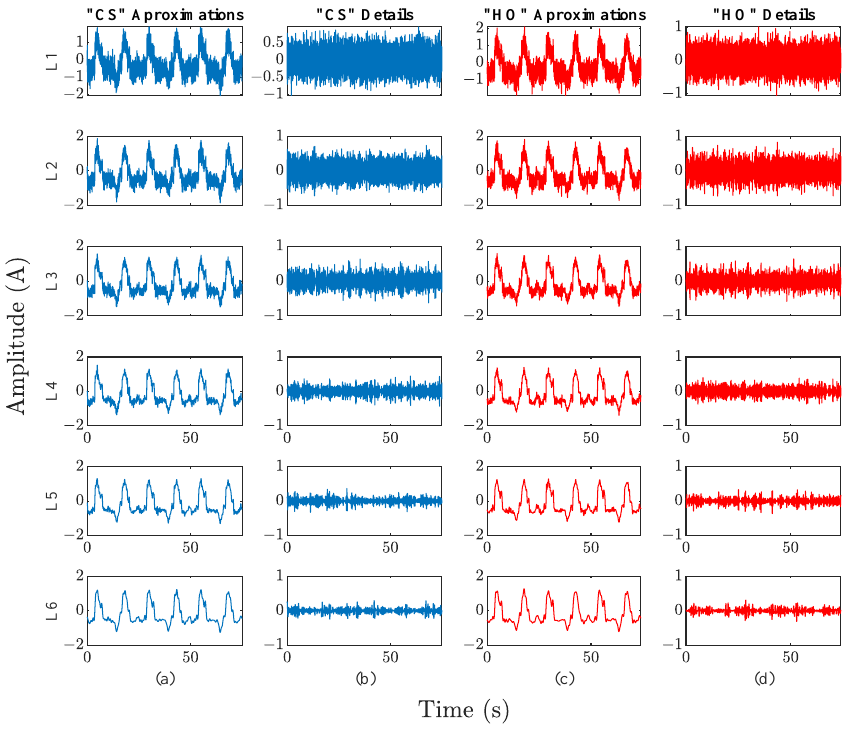
Figure 8. Signals corresponding to the time-frequency analysis of the first joint of the robot, with 5 dB noise, for half-speed case: ( a , b ) approximation and details for decomposition level six for the “CS” signal; ( c , d ) approximation and details for decomposition level six for the “HO”